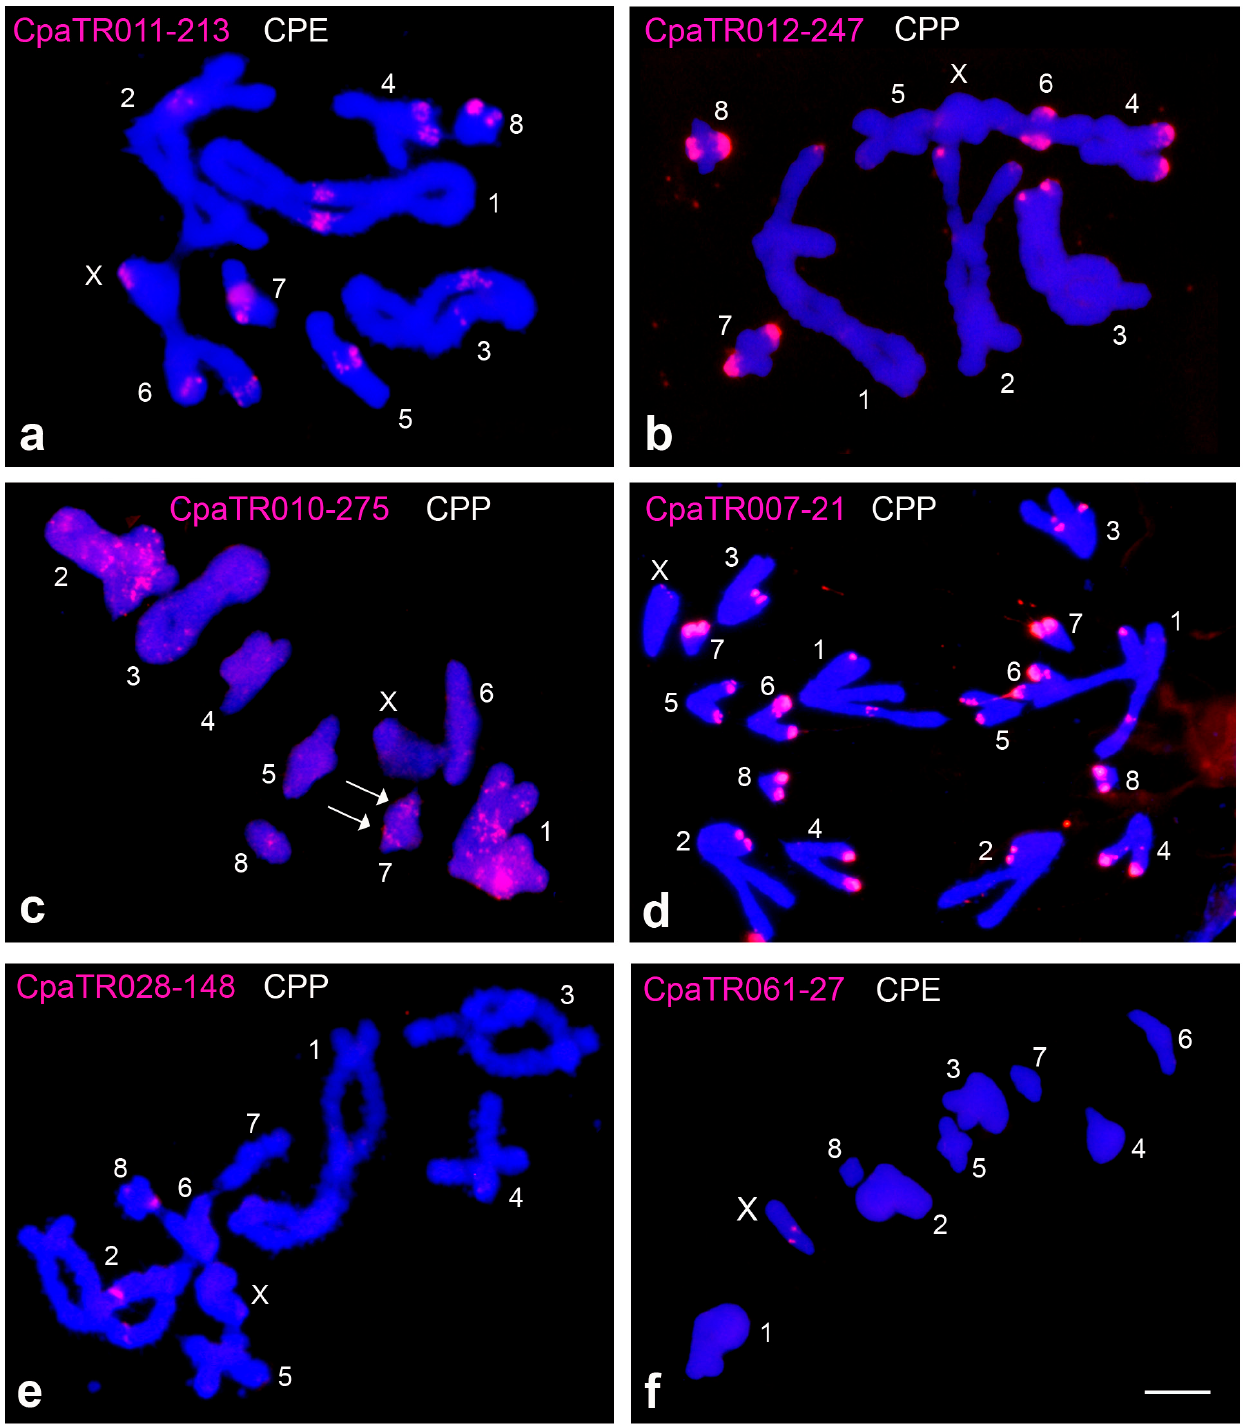
Figure 1. Examples of physical location of TRs by FISH in C. parallelus : pericentromeric bands on all chromosomes ( a ), distal bands on all chromosomes, except autosome 5 ( b ), dotted ‐ banded (DB) pattern with a defined band on autosome 7 (arrows) ( c ), distal bands on all chromosomes (and interstitial band on autosomes 1 and 4) ( d ), pericentromeric bands on chromosomes 2 and 8 ( e ), and interstitial band only on the X chromosome ( f ) (see also Tables 2 and 3). CPP = Chorthippus parallelus parallelus ; CPE = Chorthippus parallelus erythropus . Bar = 5 μ m. Table 2. Chromosome location of 50 TR families in the CPP subspecies of C. parallelus . Asterisks (*) indicate that bands were observed on only one member of a chromosomal pair. Chromosome location (pattern) could be pericentromeric (p), interstitial (i), or distal (d). B = banded, DB = dotted ‐ banded, NS = no signal, Chrom = number of chromosomes displaying bands for a given TR family. CPP = Chorthippus parallelus parallelus.